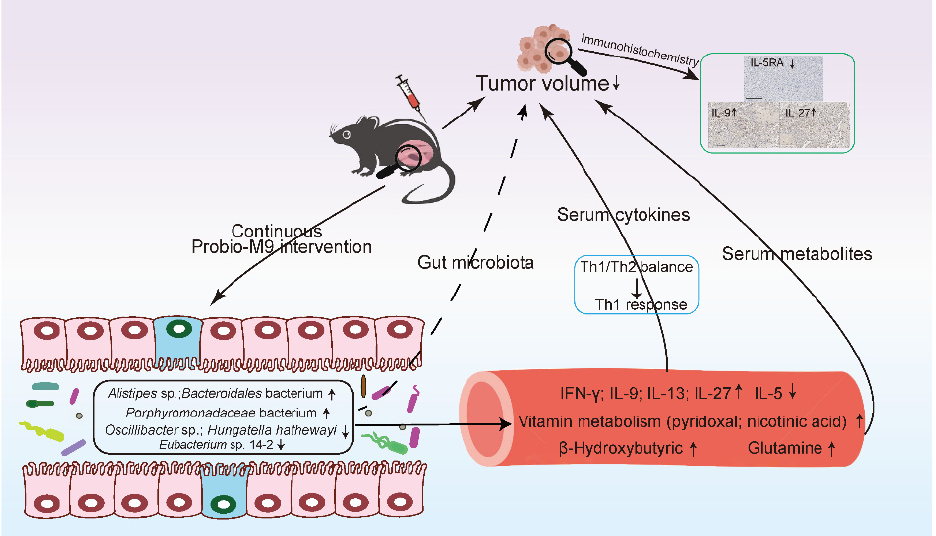
Figure 5. Proposed mechanism of Lacticaseibacillus rhamnosus Probio-M9 in inhibiting mammary tumor growth.